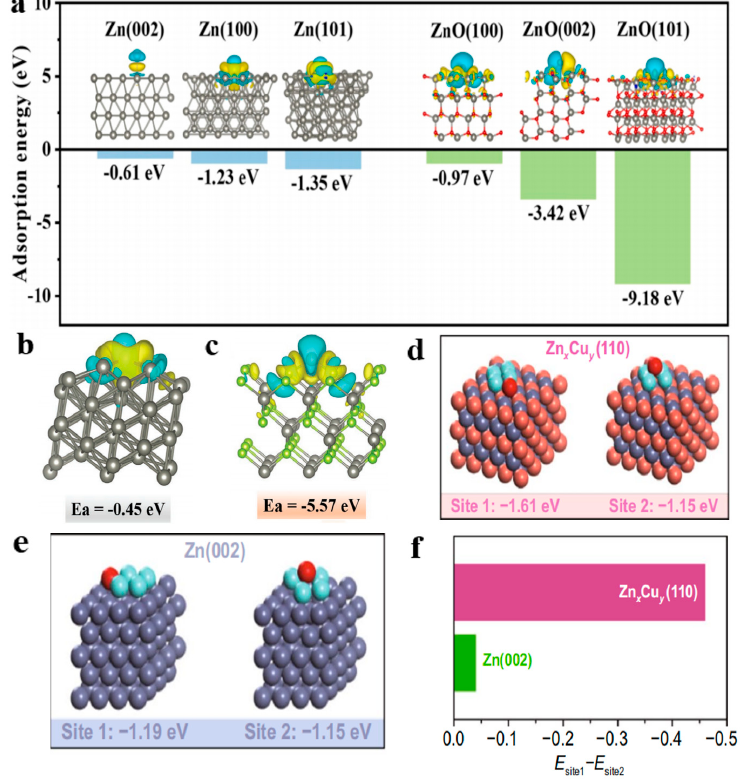
Figure 6. ( a ) DFT-calculated adsorption energies of Zn atoms on Zn and on ZnO crystal facets. Insets display the corresponding optimized atomic configurations of the adsorption complexes together with the differential charge density at the adsorption sites. Reproduced with permission [78]. Copyright 2022 Elsevier B.V. Differential charge density for the optimized structure of Zn 2+ ion absorbed on ( b ) Zn (111) and ( c ) ZnSe (100) surfaces. The yellow and cyan regions represent charge accumulation and depletion, respectively. Reproduced with permission [79]. Copyright 2021 Wiley-VCH. Zn deposition at ( d ) side site (site 1) and ( e ) top site (site 2) on the Zn (002) and Zn x Cu y (110) surfaces with different binding energies. ( f ) Comparison of energy difference between site 1 and site 2 at which Zn is deposited on the Zn (002) and Zn x Cu y (110) surfaces. Reproduced with permission [80]. Copyright 2022